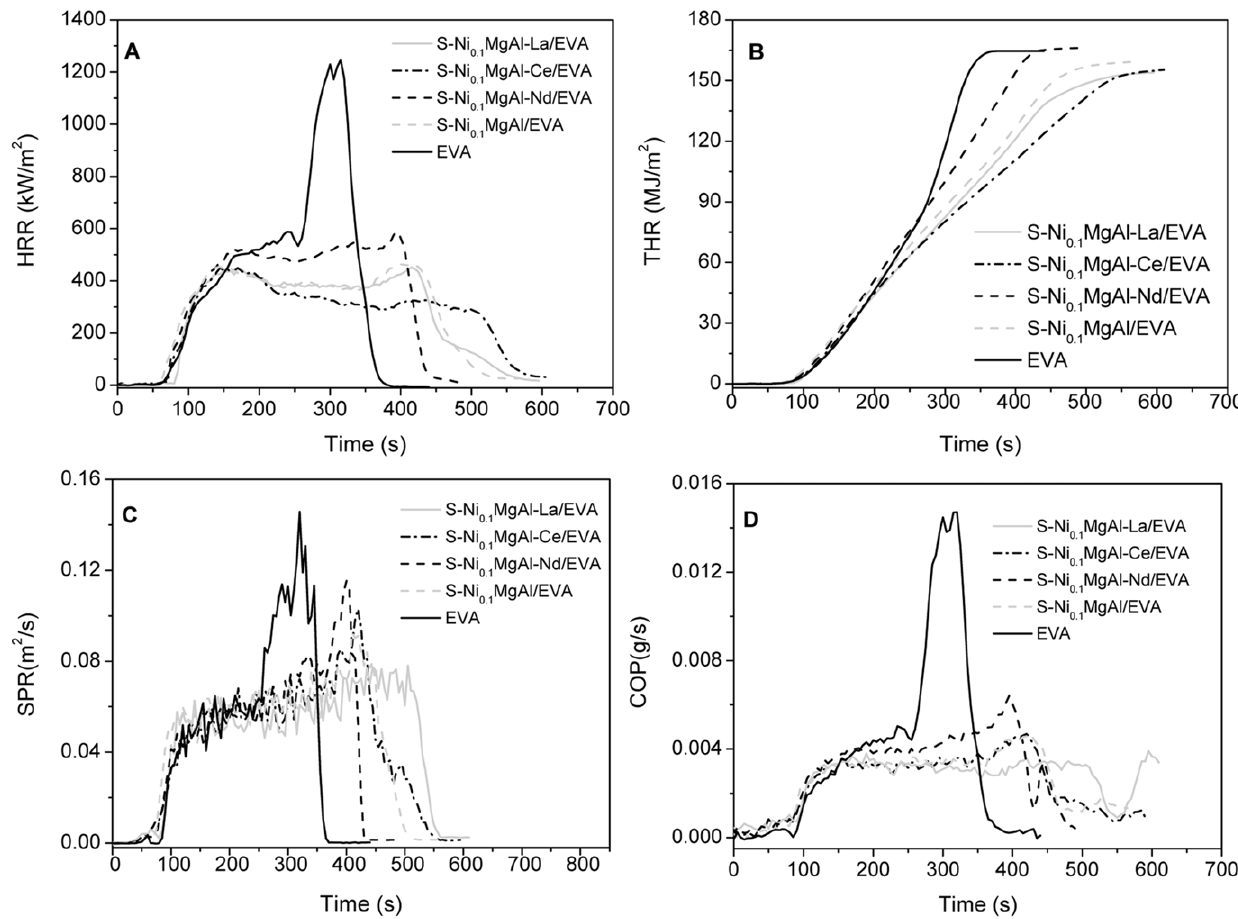
Figure 9. Cone calorimetric results of the pristine EVA and its composites with 20 wt.% loading of LDHs. A: Heat release rate (HRR) curves, B: Total heat release (THR) curves, C: Smoke production rate (SPR) curves and D: Production of CO (COP) curves.